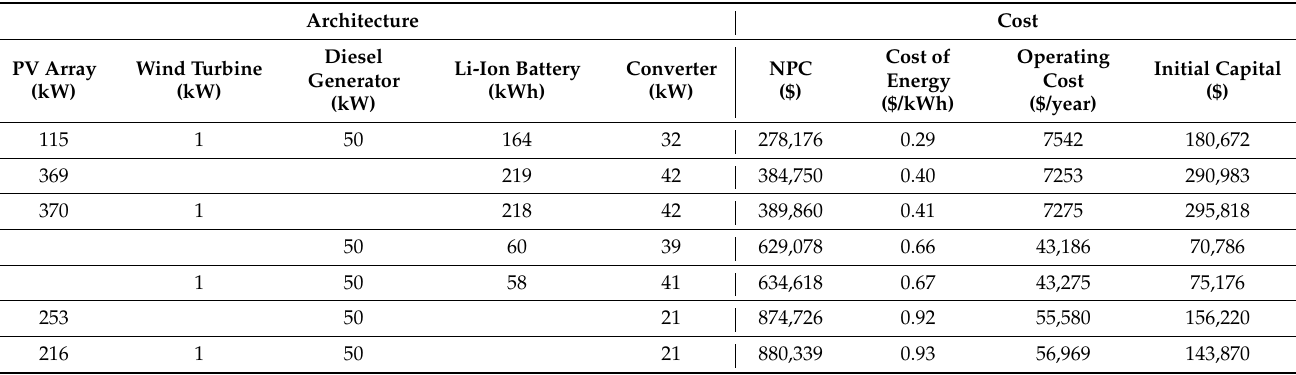
Table 6. Optimized response from the HOMER